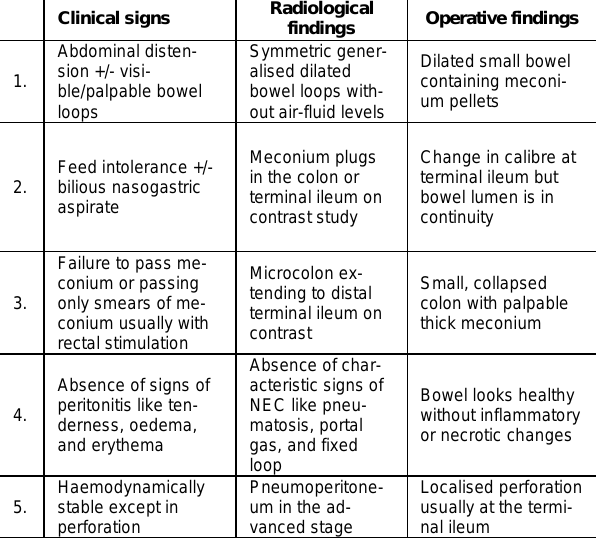
Table 1: Clinical, radiological, and operative features of FIOP Clinical signs